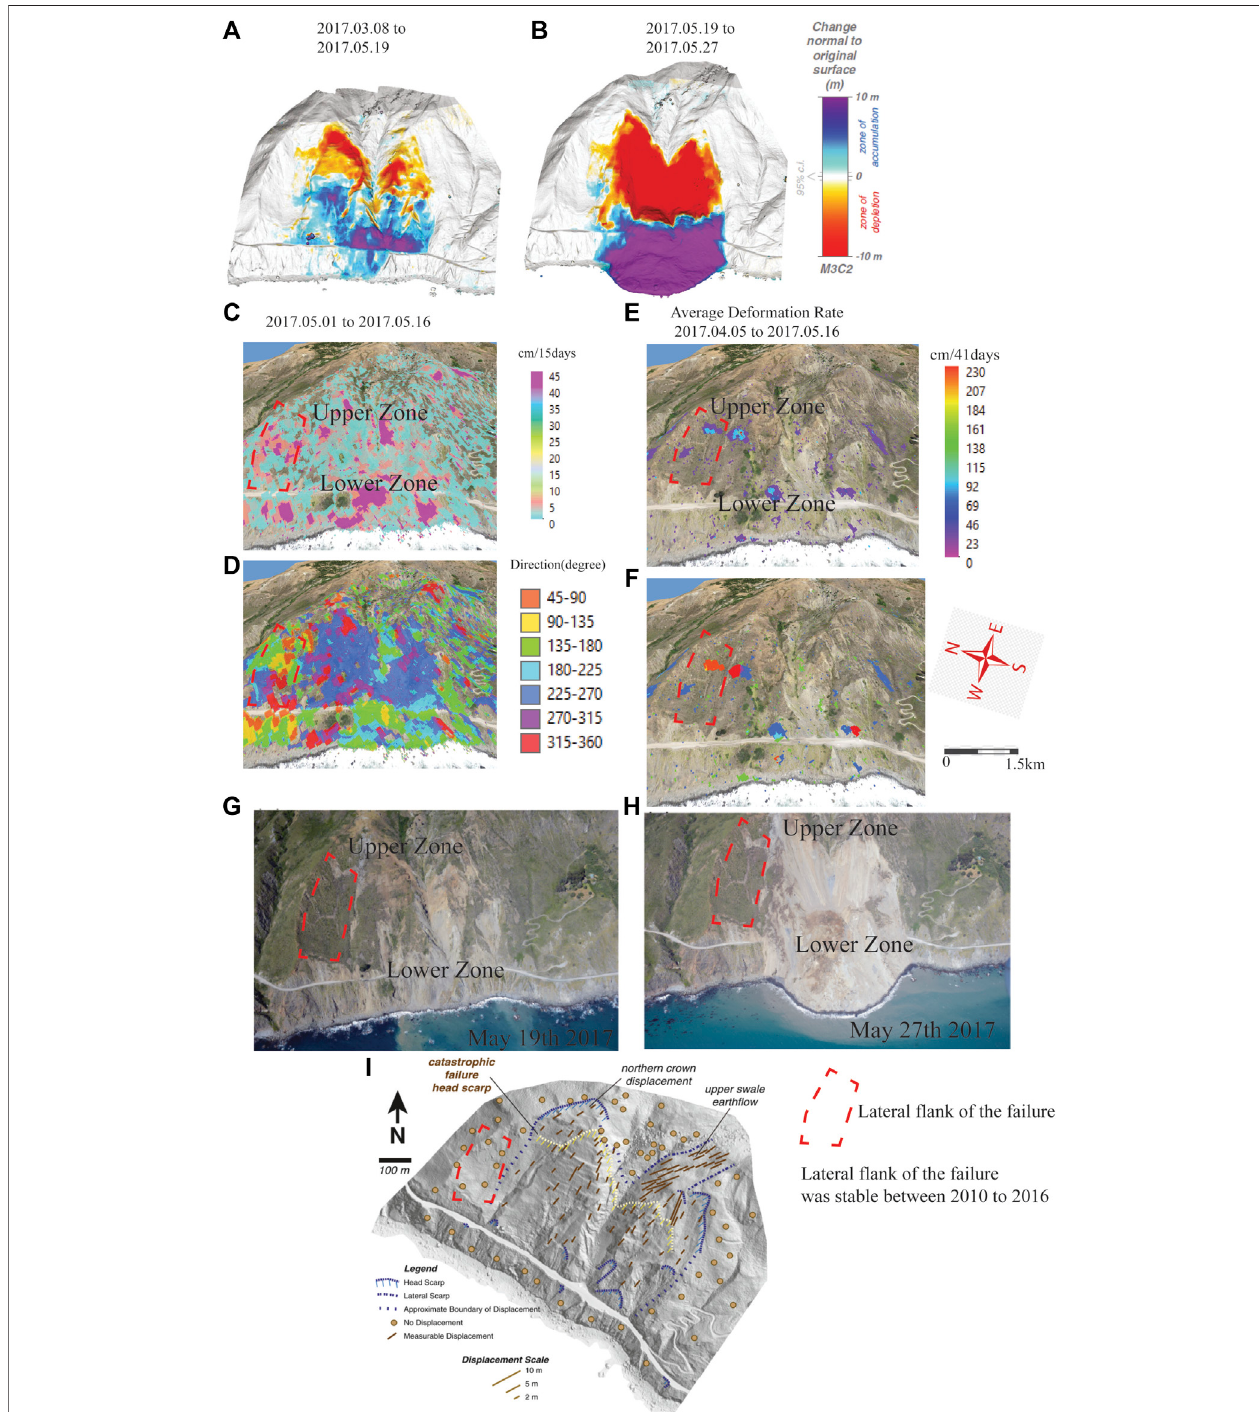
FIGURE 6 | Mud Creek landslide precursor changes. (A) Elevation change calculated from SfM digital surface model between March 8 and May 19, 2017 (1 day before failure). (B) Elevation change before and after the catastrophic failure. (C) Dynamic change detection showing horizontal displacement rates in cm per day from May 1 to May 16, 2017 (4 days before failure). (D) Displacement vector r (direction) for panel (C) . (E) Average horizontal displacement rate in cm for the 41 days calculated from stacked triplets between April 5 and May 16, 2017 (4 days before the failure). (F) Displacement vector (direction) for panel (E) . (G) Oblique UnmannedAerialVehicle(UAV)photographtaken1 daybeforetheMay20,2017,failure. (H) ObliqueUAVphotographtaken7 daysaftertheMay20,2017,failure.UAV photographs from Warrick et al. (2019). (I) Horizontal displacement map of the Mud Creek site between 2010 and 2016. Locations of observed and mapped head and lateral scarps(blue lines). The head scarp of the May 20, 2017, failure is shown for comparative purposes (yellow line). The approximate boundaries between no displacement and measurable displacement are shown with dashed lines. Shaded relief base-layer map is the May 2016 Lidar (after Warrick et al., 2019).